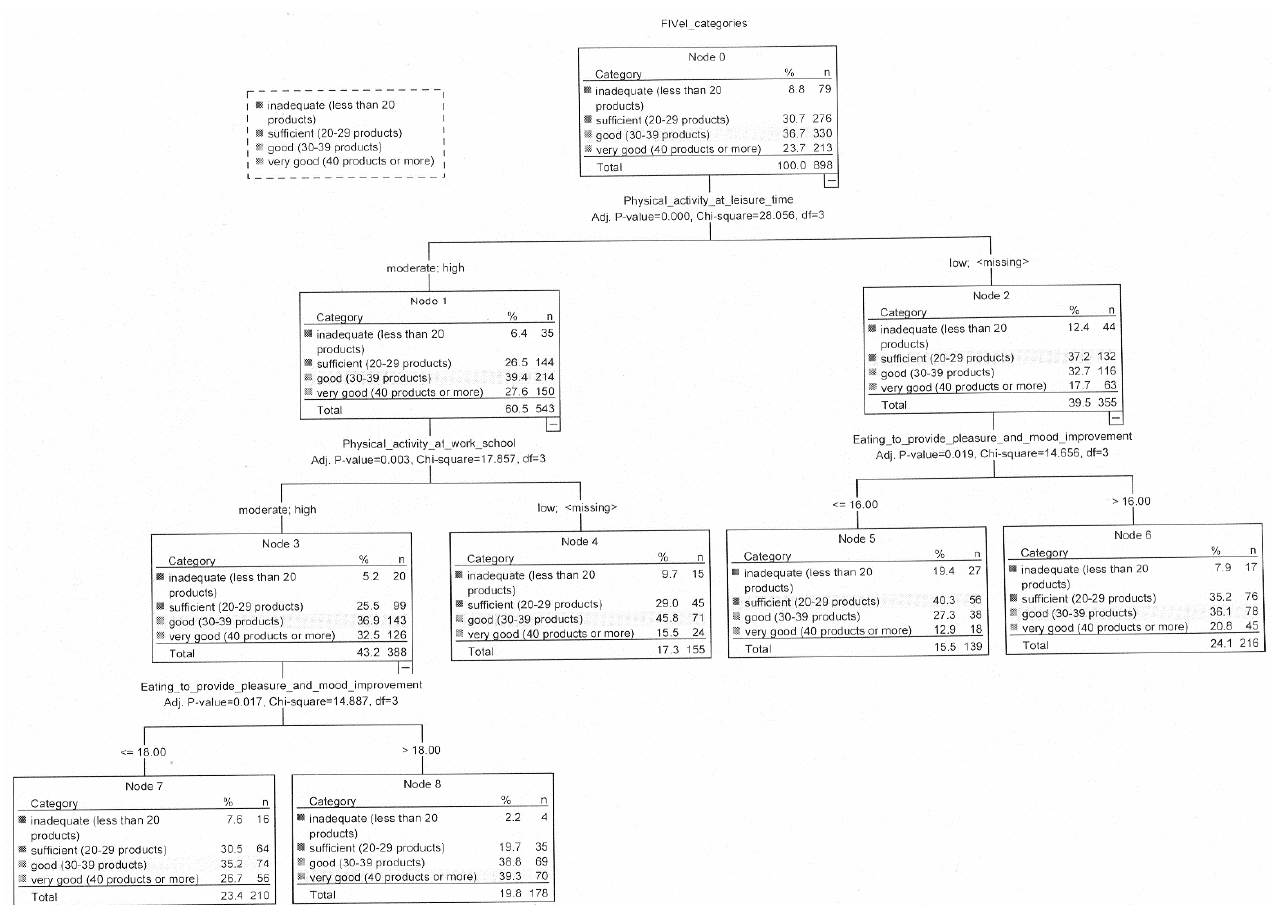
Figure 1. Relationship between food intake variety, eating addiction, selected lifestyles variables and sociodemographic characteristics in the study